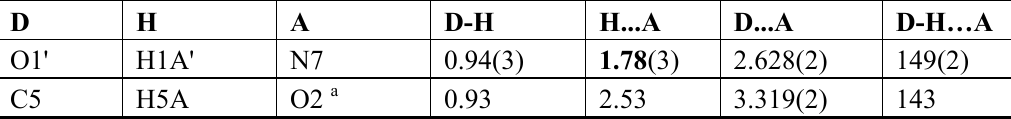
Table 4. Hydrogen bonding data for compound 13.